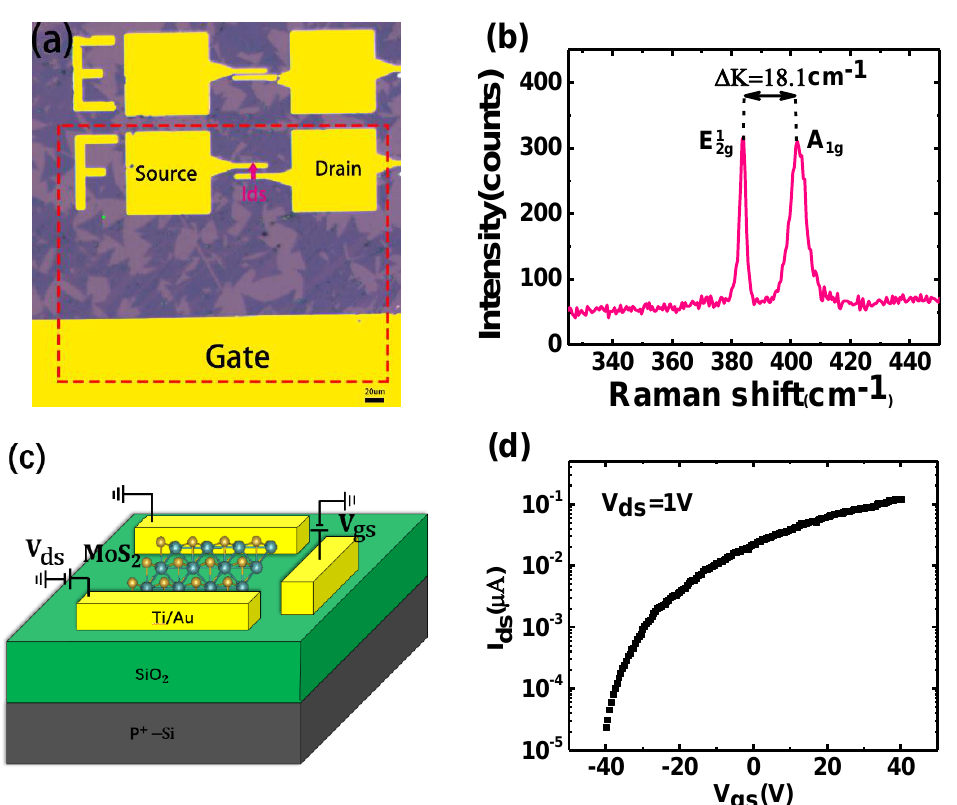
Figure 1. ( a ) The optical image of horizontal-gate device. ( b ) The Raman spectrum of monolayer MoS 2 ( c ) The schematic of the horizontal-gate monolayer MoS 2 transistor. ( d ) Transfer characteristic curve when Vds is equal to 1 V.